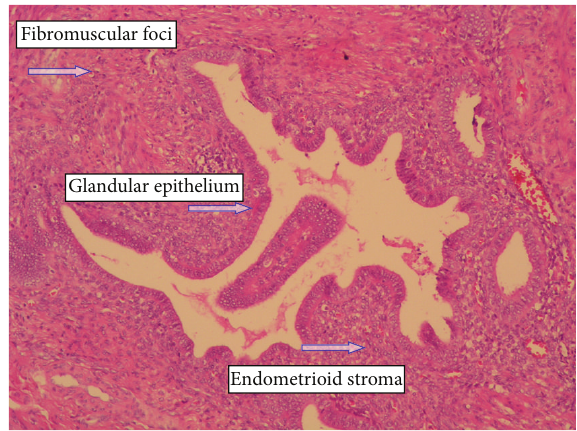
Figure 3: Darkly brown stained smooth muscle fibers of the appendix’s muscularis propria show positive reaction form smooth muscle actin surrounding endometriosis foci. IHC staining for SMA. Magnification